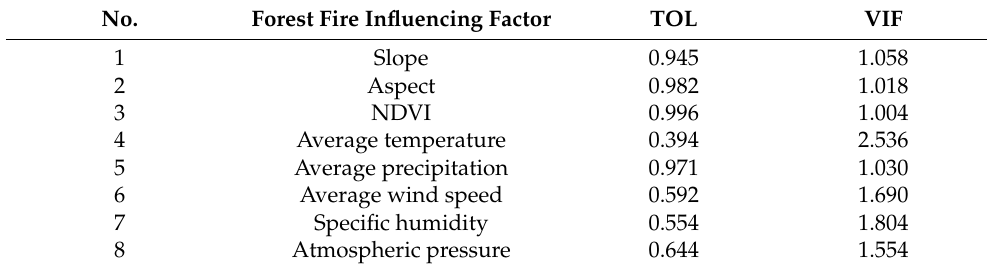
Table 2. Multicollinearity analysis of forest fire influencing